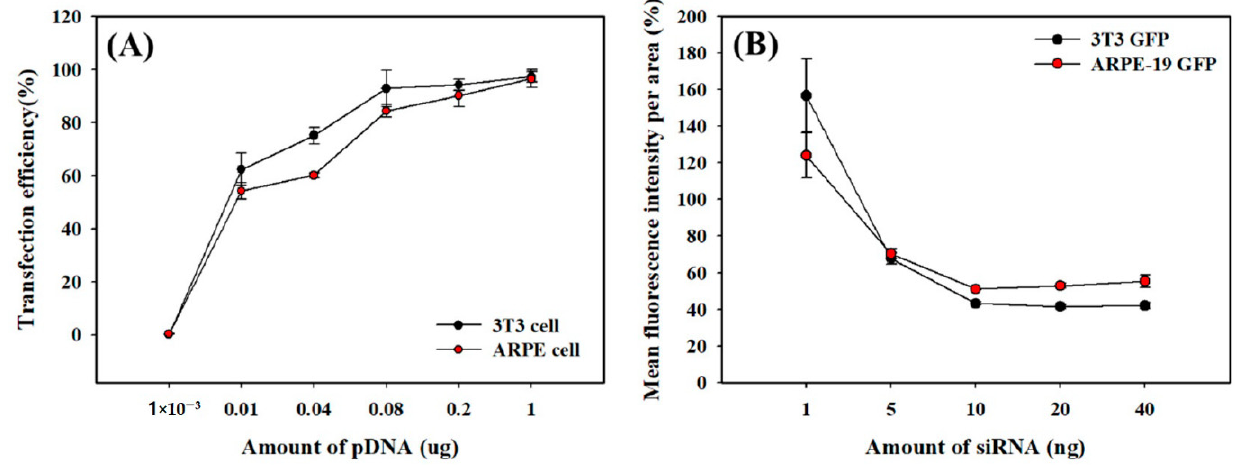
Figure 4. Effects of plasmid DNA and siRNA concentration on transfection efficiency ( A ) and fluorescence knockdown ( B ). ( A ) In 100 µ L DMEM, TEPA-BCD amount was 1.28 µ g, and plasmid DNA amounts ranged from 0.001 to 1 µ g. ARPE and 3T3 cells were treated with loaded nanoparticles. ( B ) In 100 µ L DMEM, TEPA-BCD amount was 1.28 µ g, and siRNA amounts ranged from 1 to 40 ng. ARPE-GFP and 3T3-GFP cells were treated with loaded nanoparticles for 4 h. Error bars represent the standard deviation from 8 images.